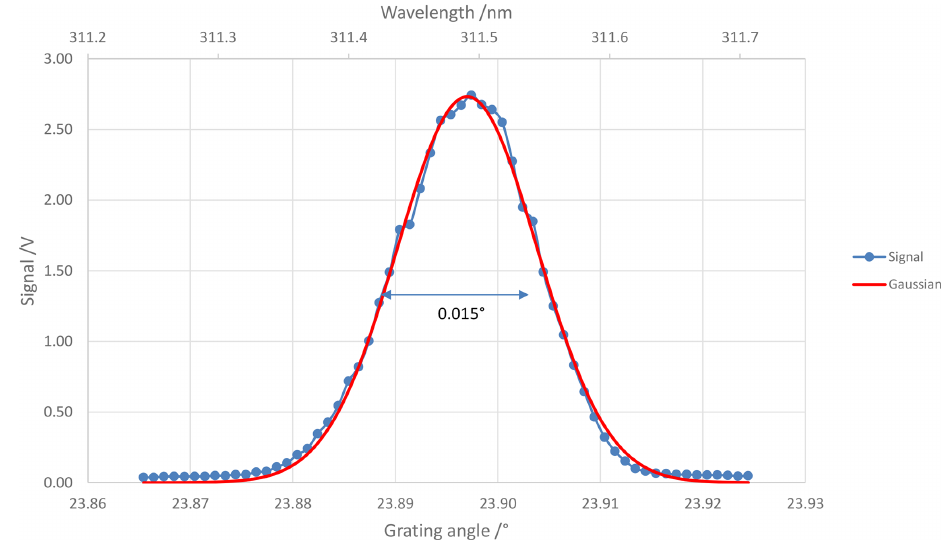
Figure 6. TuPS bandwidth measurement performed at 305nm. The width of the peak of 0.015 ◦ corresponds to spectral FWHM 0.12nm.